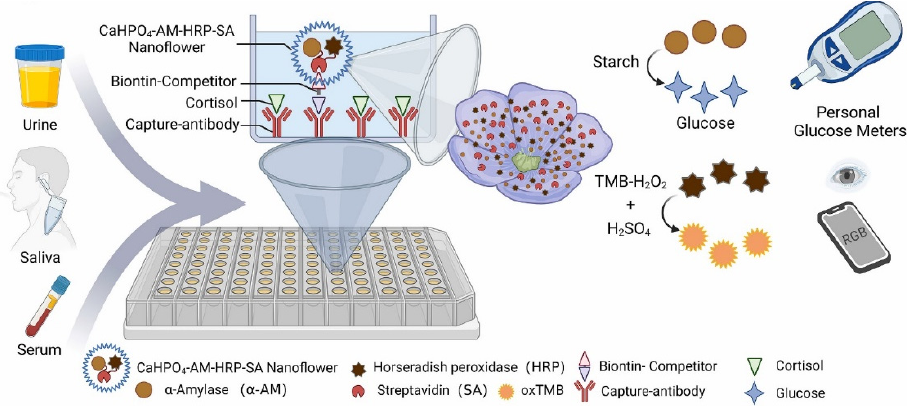
Figure 6. Schematic representation of cortisol sensing by dual-mode platform (reproduced with permission from [57]. Copyright 2022 Elsevier.).